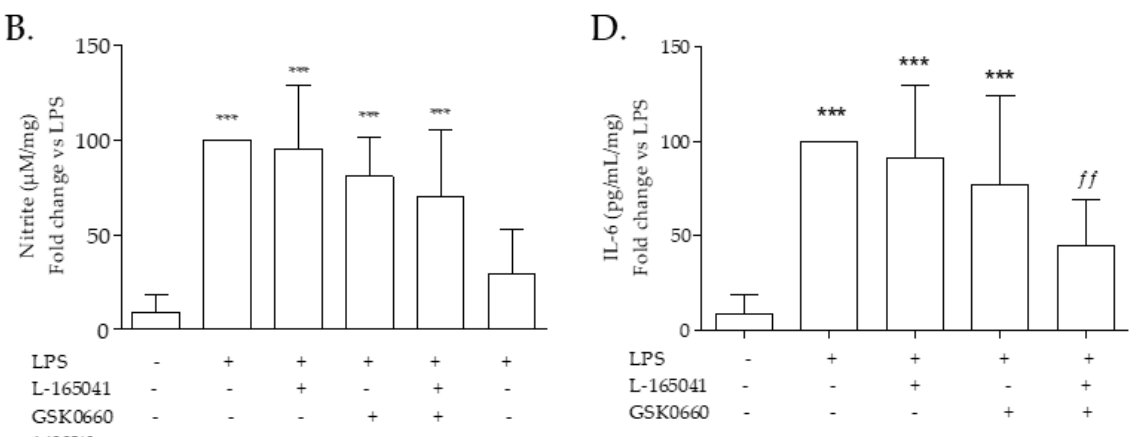
Figure 1. Nitrite (a marker for NO release) and IL − 6 production by pulmonary artery. Rat pulmonary artery rings were treated with two combinations of PPAR β / δ agonist-antagonist and iNOS inhibitor 1400W: ( A – C ) 100 nM GW0742—1 µ M GSK3787—100 µ M 1400W ( B – D ) 1 µ M L − 165041—1 µ M GSK0660—100 µ M 1400W. NO and IL − 6 production